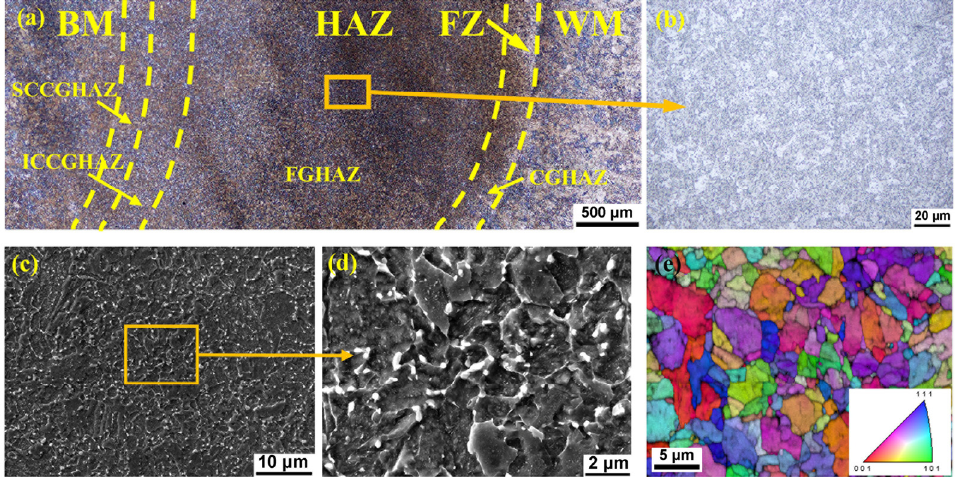
Figure 5. Microstructure of the compressor part HAZ: ( a ) the entire microstructure of the HAZ; ( b – d ) the microstructure of FGHAZ; ( e ) the inverse pole figure of EBSD in the FGHAZ.